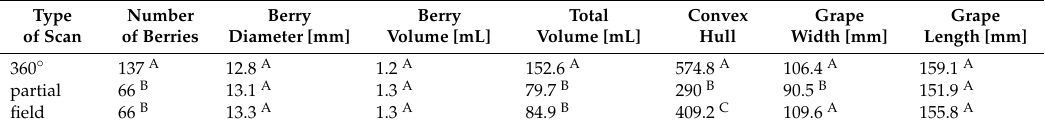
Table 4. Comparison of 3D bunch traits obtained from three different types of grape scans: fast and non-invasive field scans vs. invasive partial/360 ◦ scans in the lab. Different letters indicate significant differences. One-way-ANOVA with α < 0.001. n =